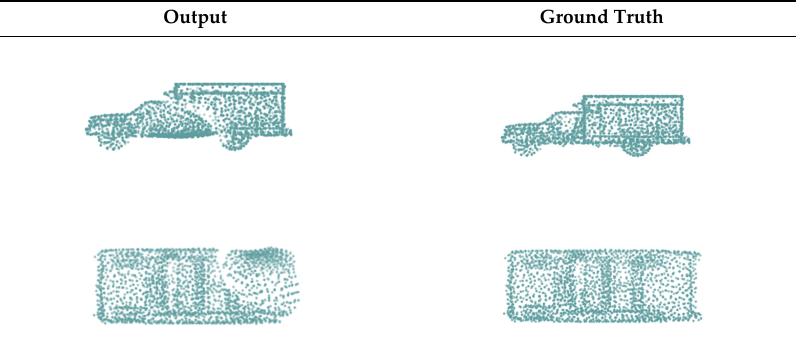
Figure 6. Some point cloud shapes with poor completion.